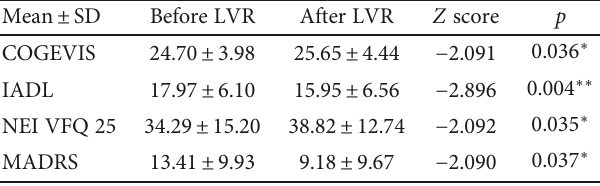
Figure 2: Receiver operating characteristic (ROC) curve of the COGEVIS to diagnose cognitive impairment. AUC: area under the curve. A yellow line is drawn at a 45-degree angle tangent to the ROC curve. This marks a good cuto ff point under the assumption that false negatives and false positives have similar costs. In this case, a COGEVIS below 24 yielded a sensitivity of 66.7% and a speci fi city of Table 2: Comparison of cognition, functional ability, quality of life, and depression before and after low vision rehabilitation (LVR).